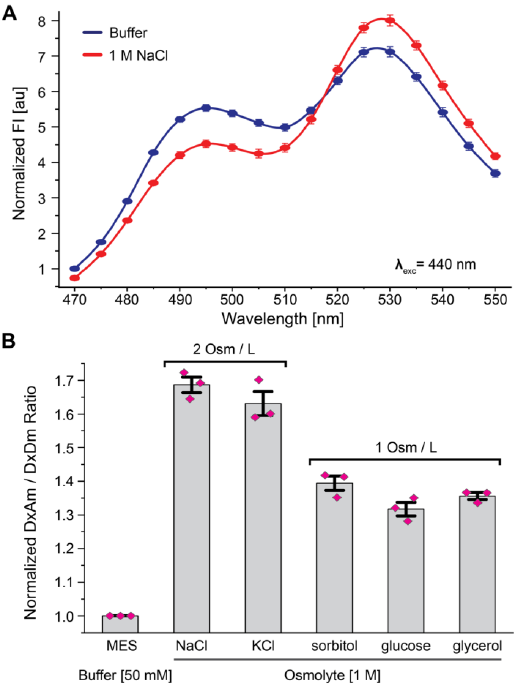
Figure 3. Characterization of the OzTrac-MSL10-34 sensor. ( A ) Emission spectra of yeast cells expressing OzTrac-MSL10-34 exposed to buffer with or without NaCl. ( B ) Response to osmolytes: NaCl, KCl, sorbitol, glucose, or glycerol (DxAm/DxDm) elicit ratiometric changes approximately proportional to solution osmolality (indicated as Osm/L). Axes and formatting as in Figure 2. Similar to OzTrac-MscL-36, diverse osmolytes were able to elicit OzTrac-MSL10-34 DxAm/DxDm ratio changes (Figure 3B). The addition of 2 Osm/L KCl showed a similar ratio of DxAm/DxDm changes as NaCl (60 – 70% increase), whereas the addition of 1 Osm/L sorbitol, glucose, and glycerol yielded smaller changes in the ratio (30 – 40% in- crease) compared to NaCl and KCl, respectively.